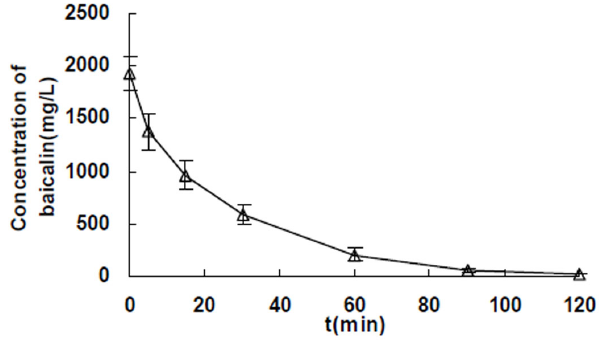
Figure 2. Mean plasma concentration–time profile of baicalin combination with phenacetin after i.v. administration baicalin at 450 mg/kg in rats. Each point represents the mean 6 SD (n=11).